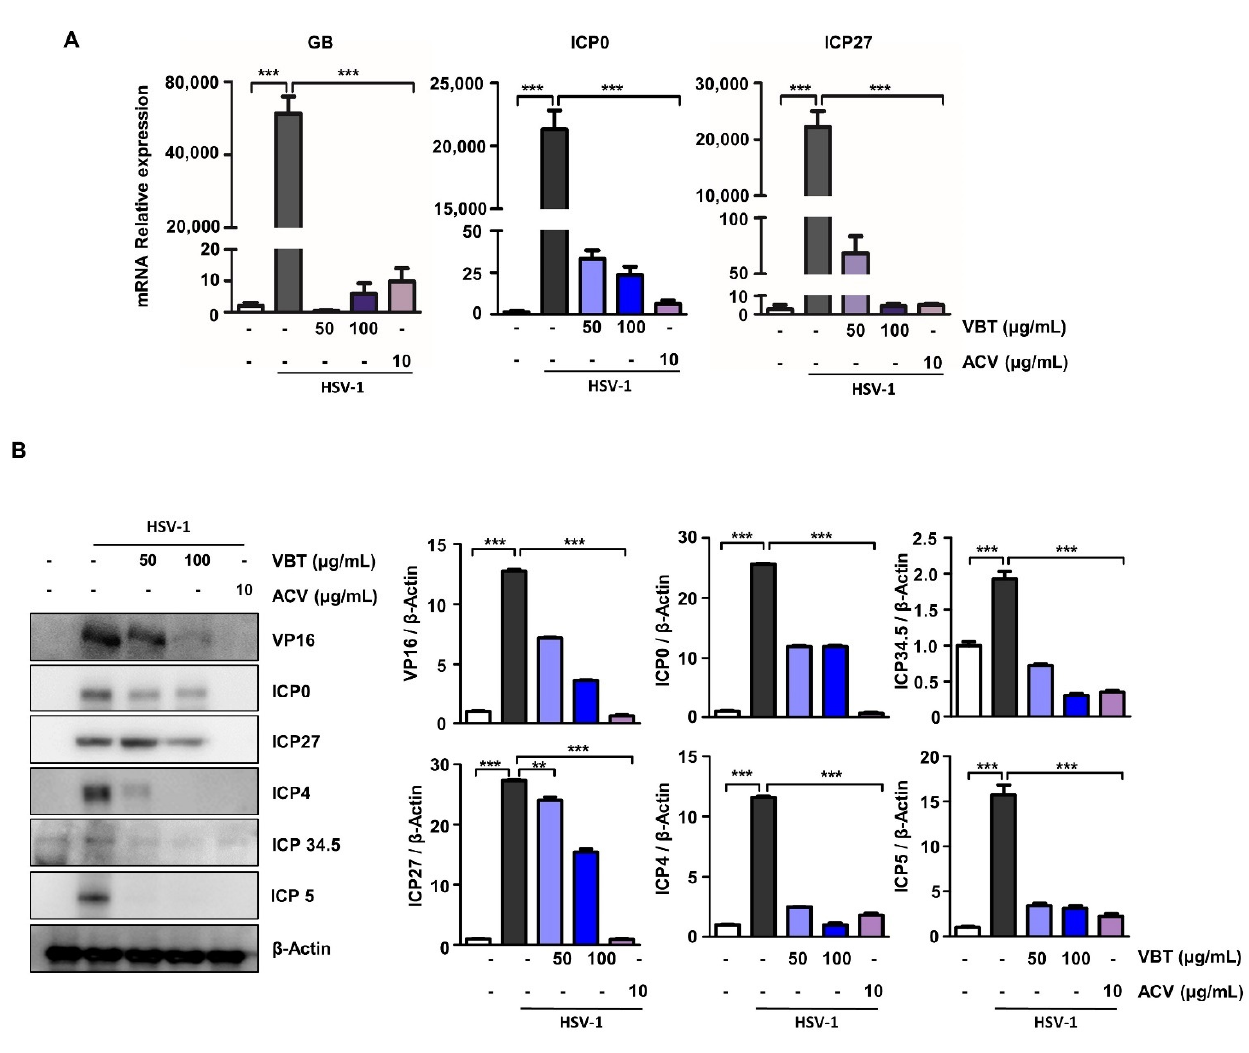
Figure 2. Anti-HSV-1 DNA replication and gene expression of VBT in Vero cells. The cells were infected with HSV-1 (MOI = 0.1) for 2 h and then replaced with fresh medium. Then, they were treated with VBT (50 µ g/mL and 100 µ g/mL) and ACV (10 µ g/mL), and incubated for 48 h. ( A ) Virus-associated factor mRNA levels were identified by real-time PCR. The expression of these proteins was normalized to that of GAPDH as a relative ratio. ( B ) Virus-associated factor proteins were identified by Western blotting. The expression of these proteins was normalized to that of β -Actin as a relative ratio. ** p < 0.01, *** p < 0.001 vs. HSV-1 treatment cells.